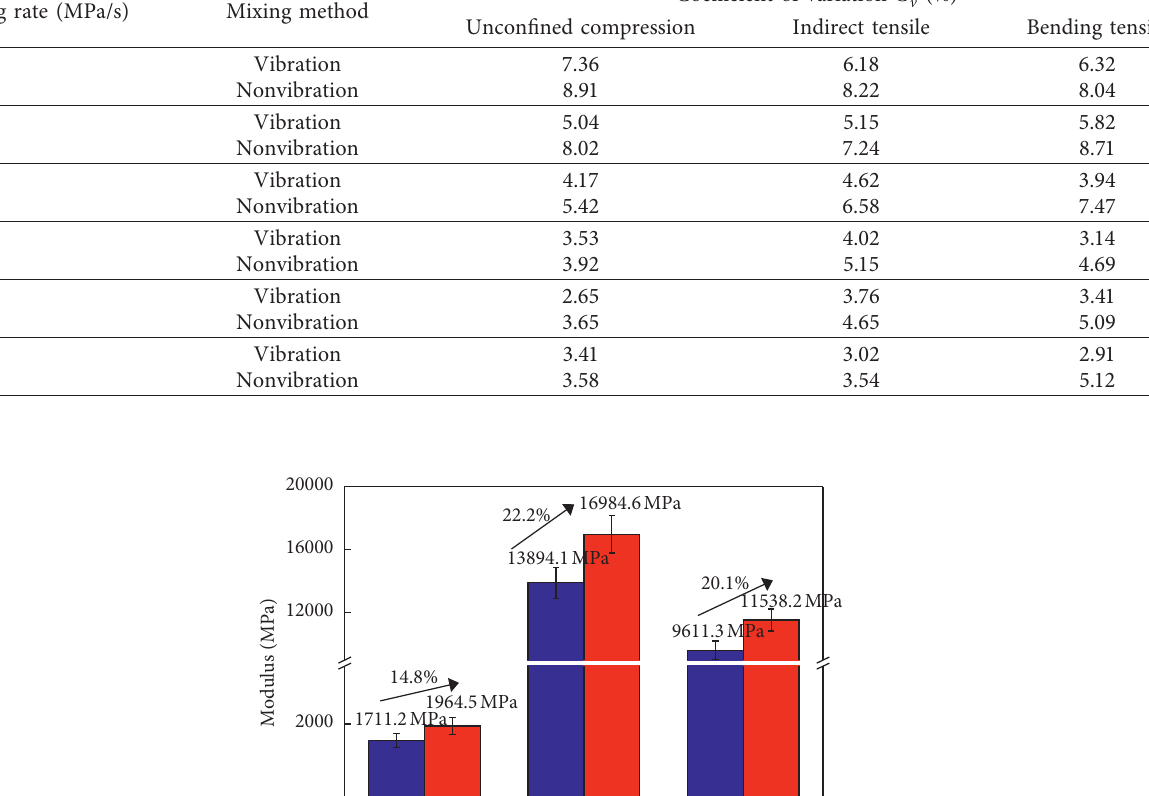
Table 4: Coefficient of variation of strengths of specimens prepared by vibratory and nonvibratory mixing under different stress states. Loading rate (MPa/s)